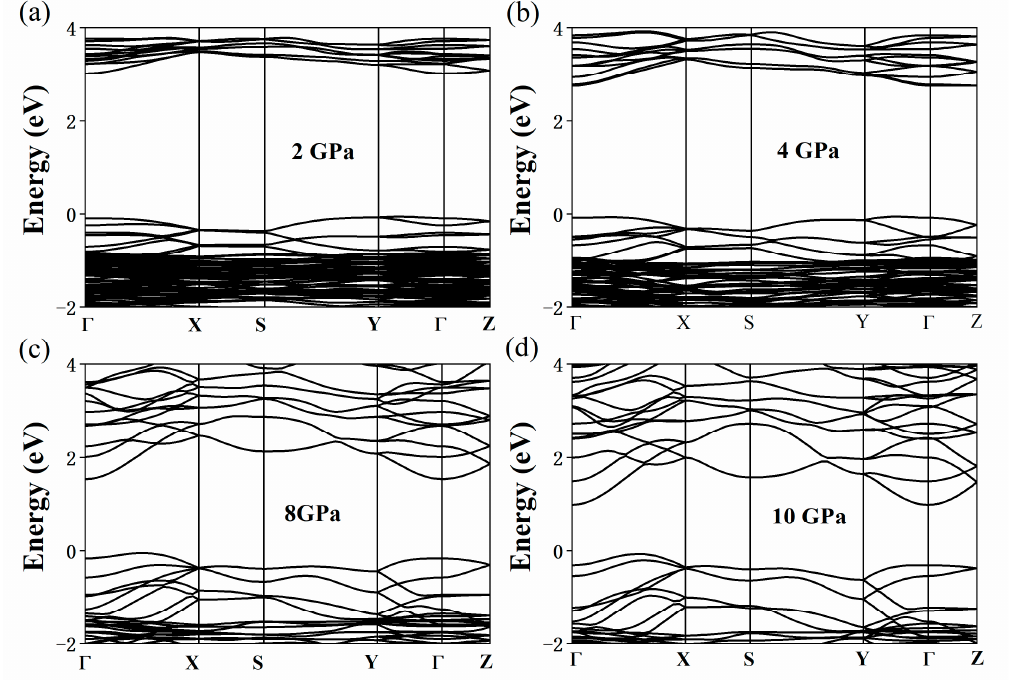
Figure 5. Calculated band structure of the Cs 3 Bi 2 Cl 9 perovskite under the pressures of 0 ( a ), 4 ( b ), 10 ( c ), and 40 GPa ( d ).